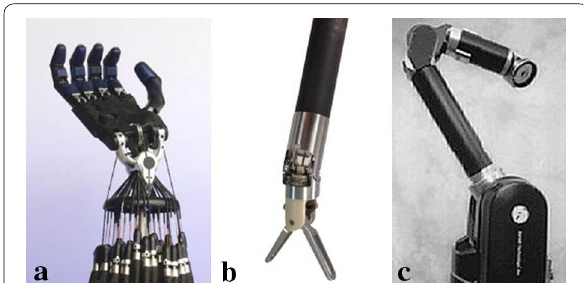
Figure 1 ( a ) Shadow Dexterous Hand (Shadow Robot Company, London, UK); ( b ) A robotic device for an invasive surgery (Tianjin University, Tianjin, China); ( c ) WMATM arm (Barrett Technology, Inc., Cambridge, Massachusetts, USA)